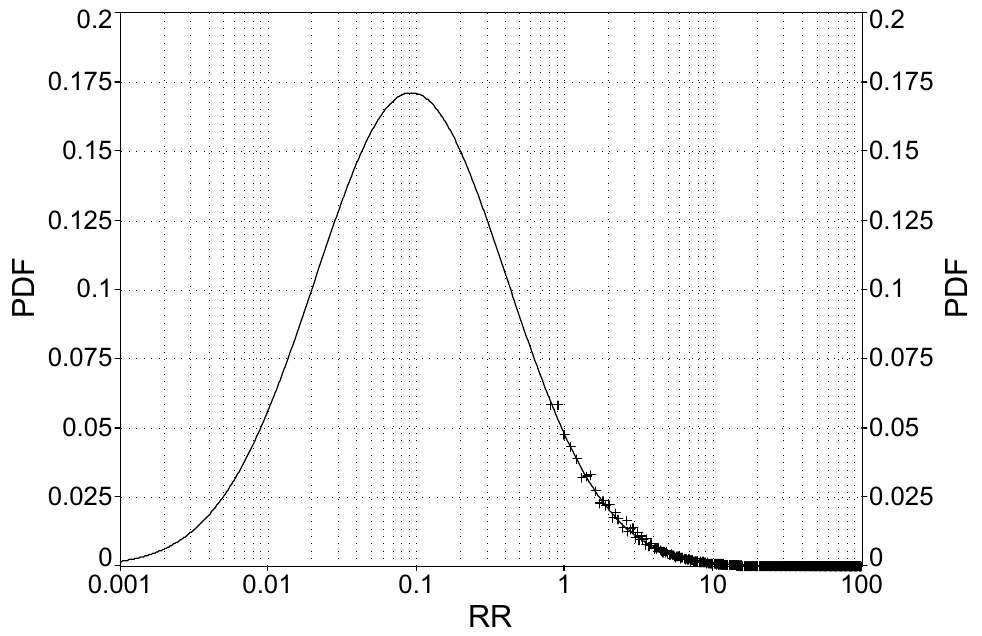
Figure 9. Rain rate distribution-PR (near nadir). Points marked by “+” represent the RRs near the nadir of the curve, and the solid line denotes the probability